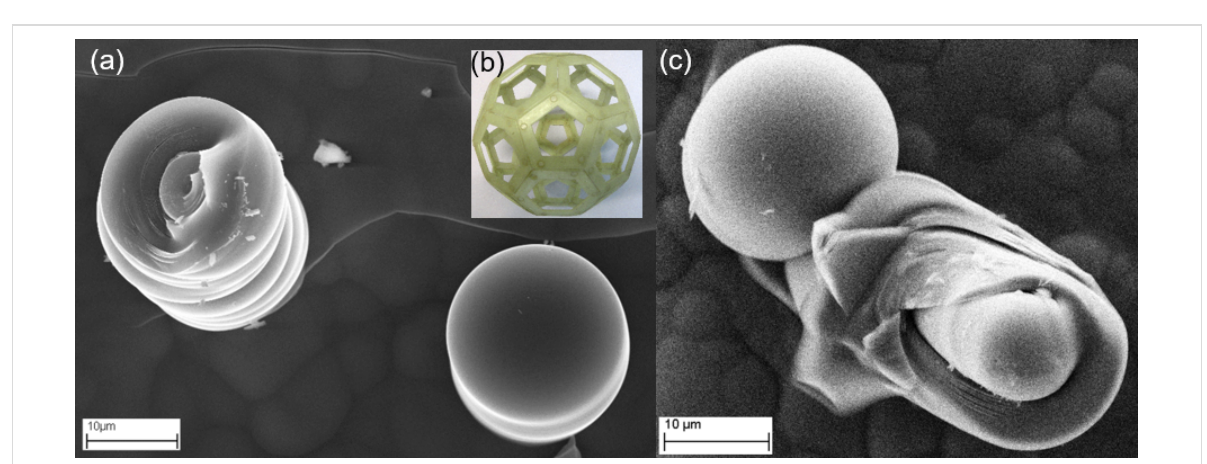
Figure 2: (a) SEM overview image of two glassy carbon tubules; the one on the right has its fullerene dome intact and the one on the left has a frac- tured fullerene dome giving insights into the internal concentric structure; (b) inset of a model of a fullerene; (c) SEM overview image of two glassy carbon tubules; the one on the left has its dome intact and the one on the right is fractured showing some of the inner intact fullerene domes.